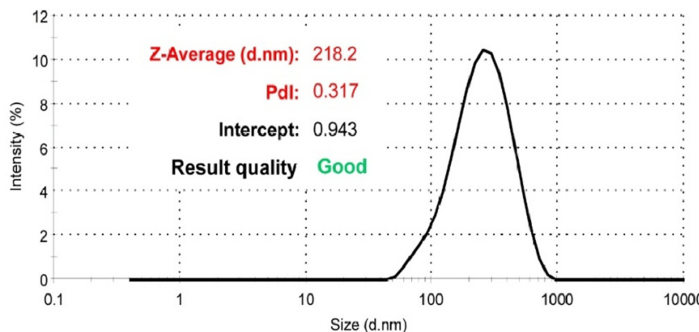
Fig.1. Size and PDI of extract-loaded liposomes